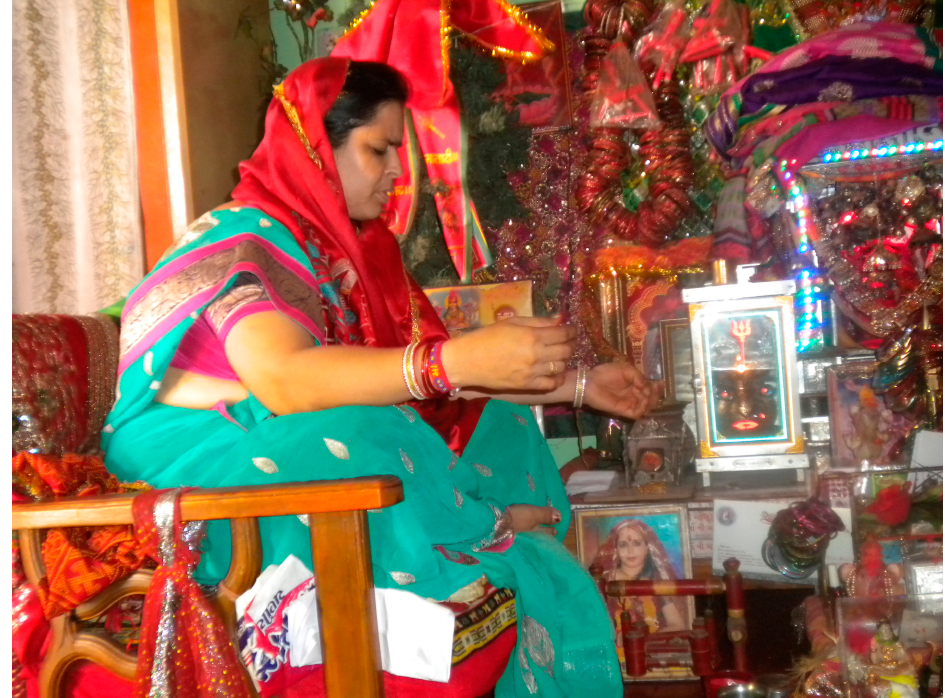
Figure 2. Anitabahen in her home shrine in Gandhinagar. Photo by author.